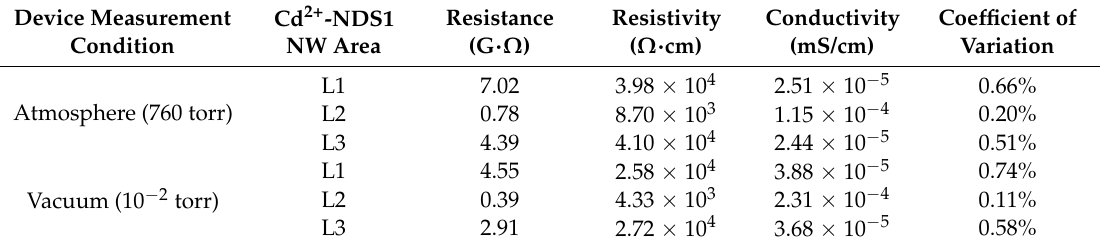
Table 2. Resistance, resistivity and conductivity data of L1, L2 and L3 sections of a selected Cd 2+ - NDS1 NW with four